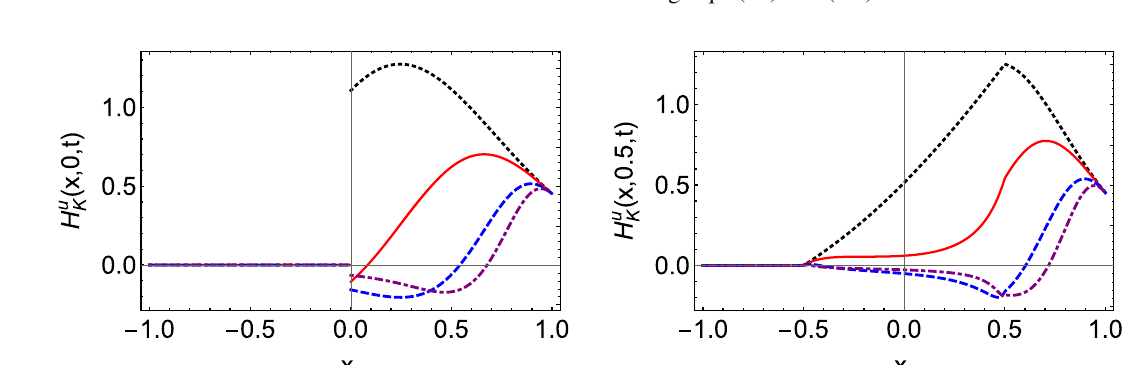
Fig. 5 Kaon u quark vector GPDs (left panel: ξ = 0, right panel: ξ = 0 . 5) with different t : black dotted line – t = 0 GeV 2 , red line – t = − 1 GeV 2 , blue dashed line – t = − 5 GeV 2 , purple dotdashed line – t = − 10 GeV 2